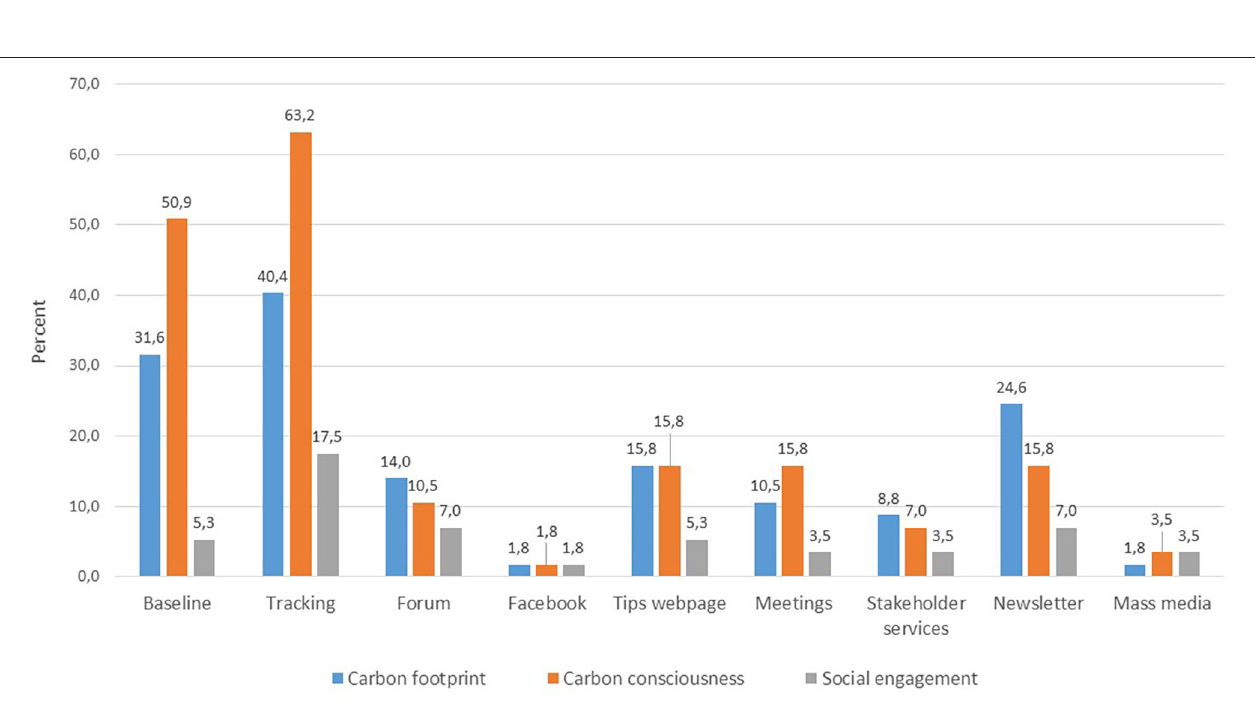
FIGURE 3 | Self-reported impact of intervention formats (x-axis) on participants’ carbon footprint, climate consciousness, and social engagement (y-axis: percentage “agree”). Source: Own Data.